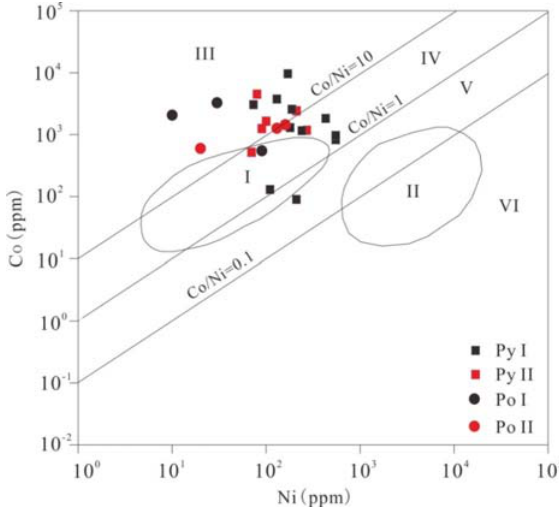
Figure 9. Ni vs. Co diagrams for pyrite and pyrrhotite from massive and lamellar ores of the Dongguashan copper (gold) deposit (References [70,72]). I: deposit related to magmatic–hydrothermal solutions; II: Cu–Ni sulfide deposit; III, IV: magmatic and hydrothermal fields; V, VI: sedimentary and sedimentary-reformed field (Note: I, II stand for the data of pyrrhotite; III-VI regions stand for the data of